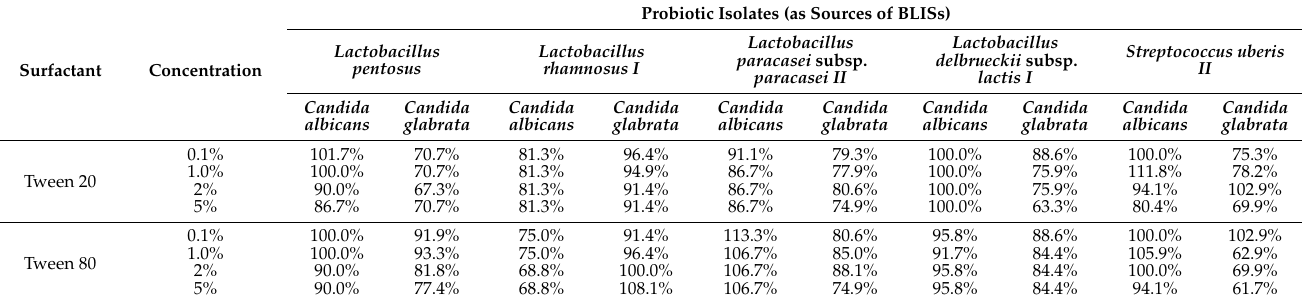
retained 75% of its activity against C. glabrata at 20% concentration of ethanol for 4 h. (Table 2). BLISs retained different levels of activity after treatment with surfactants. In some cases, an enhancement of activity (>100%) was observed (Table 3). Table 3. Effect of surfactants on bacteriocin-like inhibitory substances (BLISs) activity against Candida albicans and Candida glabrata , as indicated by residual activity (%).